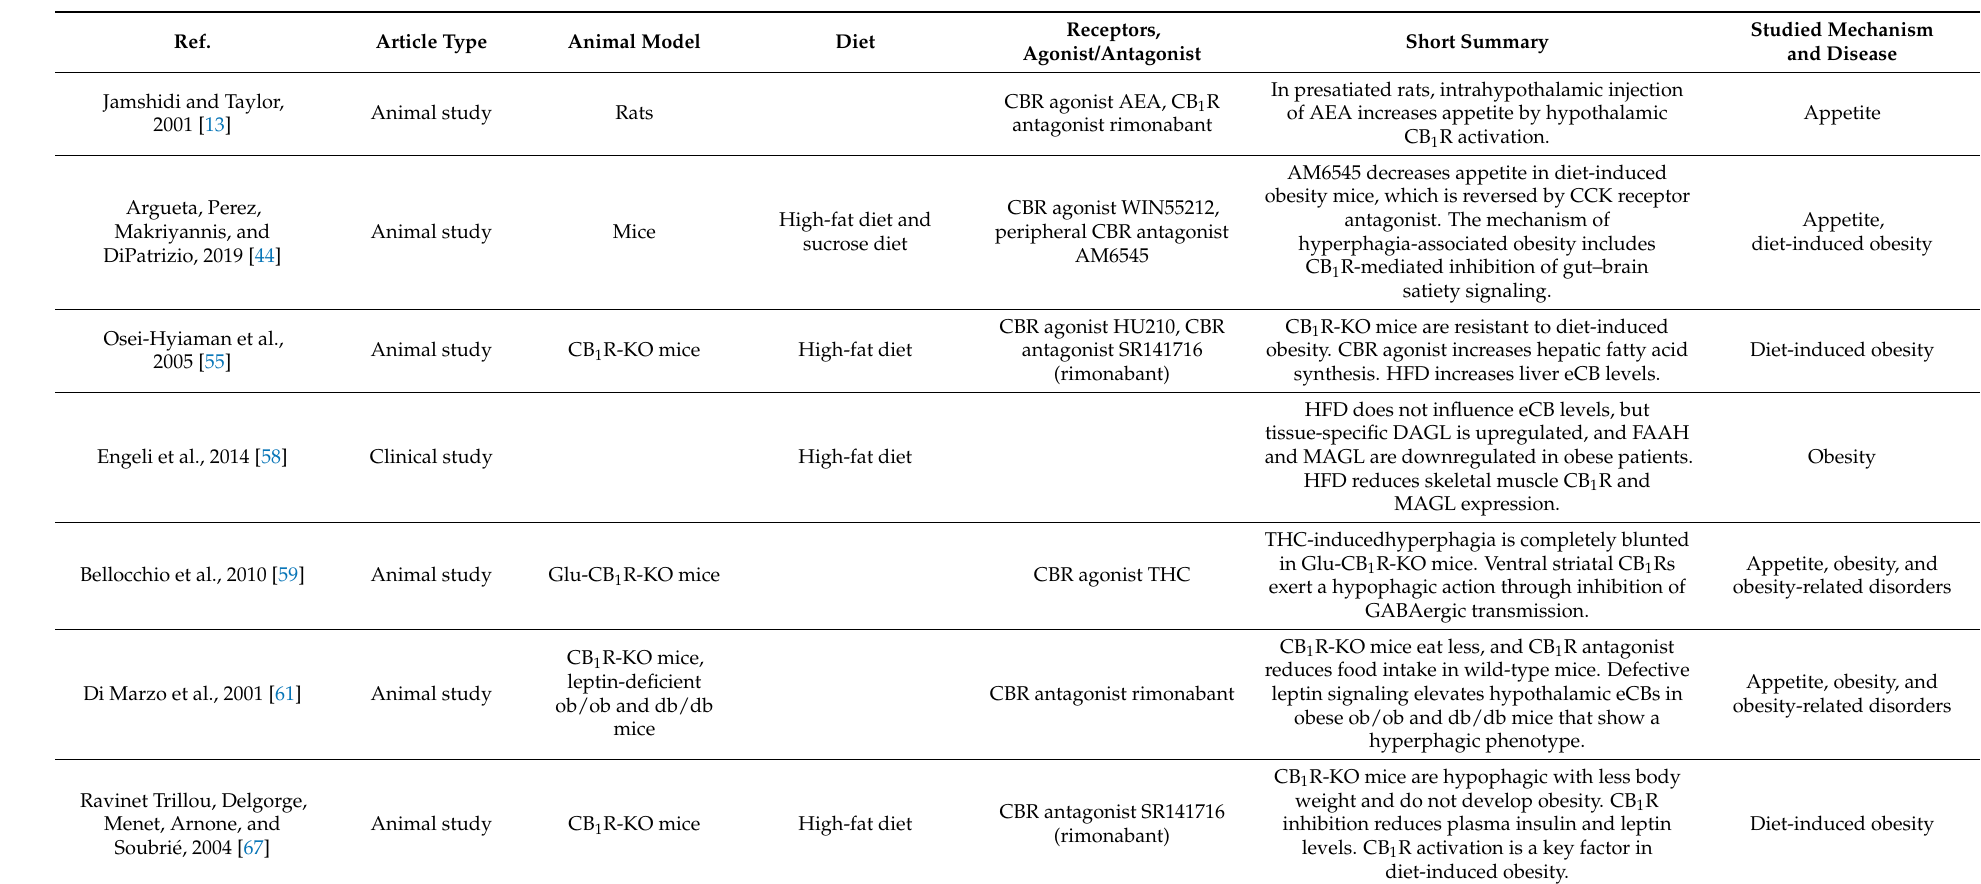
Table 1. Effects of endocannabinoid system and cannabinoids on appetite and obesity. Analysis from references. Original and review articles discussing CB receptor- dependent methods (KO mice, agonists, antagonists) are emphasized. CBR, cannabinoid receptors, CB 1 R and CB 2 R, cannabinoid receptors type 1 and 2, CCK, cholecystokinin, KO, knockout, HFD, high-fat diet, eCB, endocannabinoid, ECS, endocannabinoid system, DAGL, diacylglycerol lipase, MAGL, monoacylglycerol